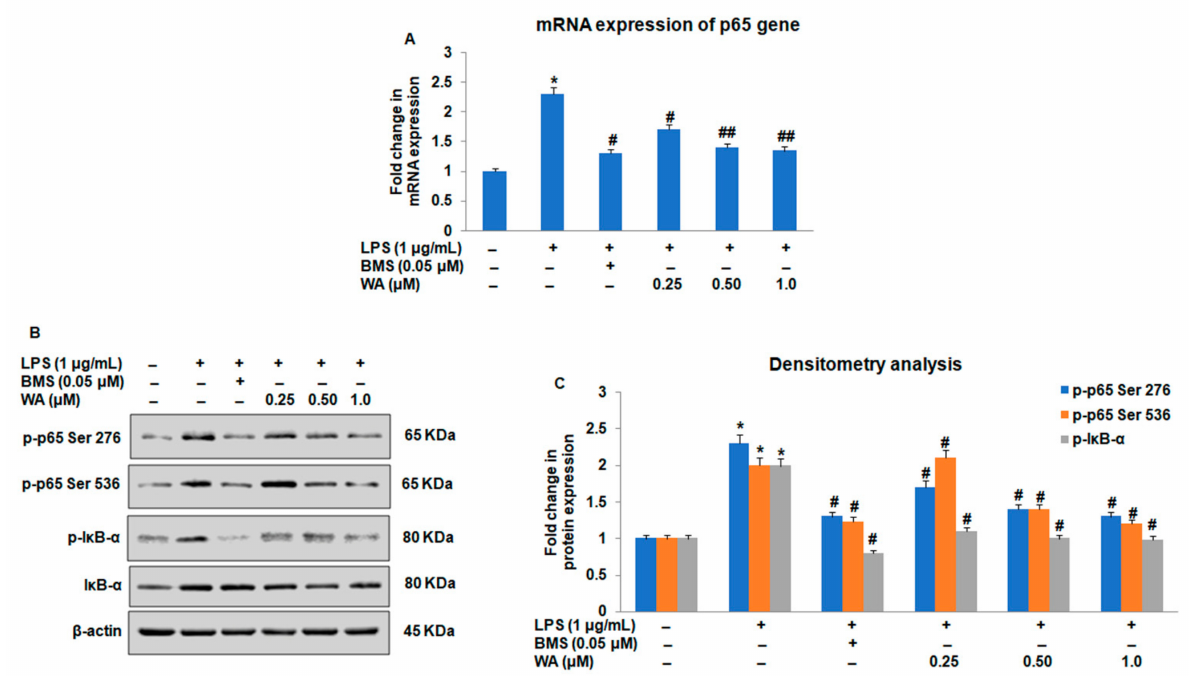
Figure 5. Effect of WA on the LPS-stimulated inflammatory signaling pathway in peritoneal macrophages. ( A ) Histograms represent the mRNA expression as determined by RT-quantitative PCR of NF-kB (p65) in LPS (1 µ g/mL)-stimulated peritoneal macrophages exposed to varying doses of WA, along with the BMS (0.05 µ M), LPS-stimulated, and untreated control groups, after 48 h. ( B ) Protein expression and phosphorylation status by immunoblotting of p-65 and IkB of LPS (1 µ g/mL)-stimulated peritoneal macrophages exposed to varying doses of WA, along with the BMS (0.05 µ M), LPS-stimulated, and untreated control groups, after 48 h. ( C ) Histogram represents fold changes in protein expression as determined by densitometry of p-65 and IkB of LPS (1 µ g/mL)- stimulated peritoneal macrophages exposed to varying doses of WA, along with the BMS (0.05 µ M), LPS-stimulated, and untreated control groups, after 48 h. Experimental data are presented as the mean ± SEM of three or more independent experiments. * p ≤ 0.05 (comparison vs. LPS only), # p ≤ 0.05, and ## p ≤ 0.01 (comparison vs. +LPS) are statistically